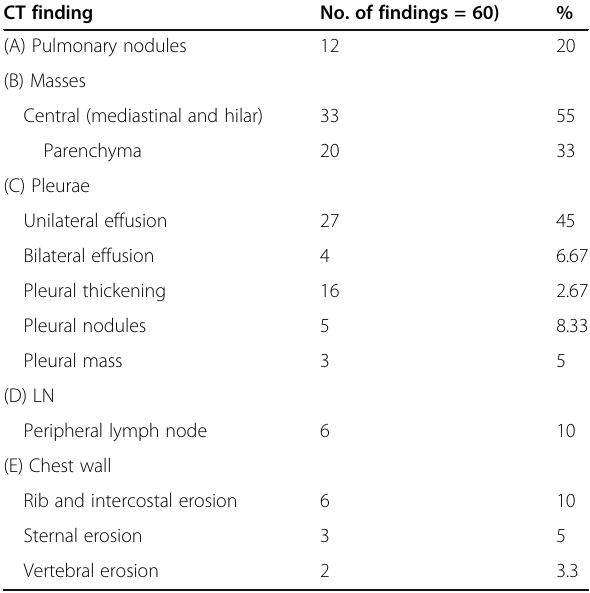
Table 5 Assessment of pulmonary nodules by US in comparison to